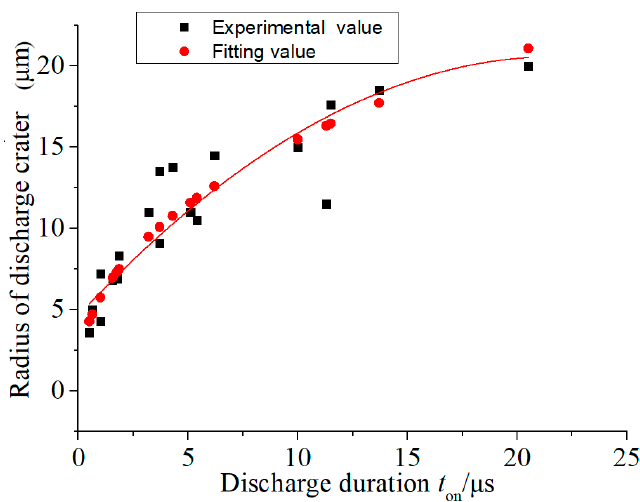
Figure 7. Experimental and fitting values for the discharge crater radius.